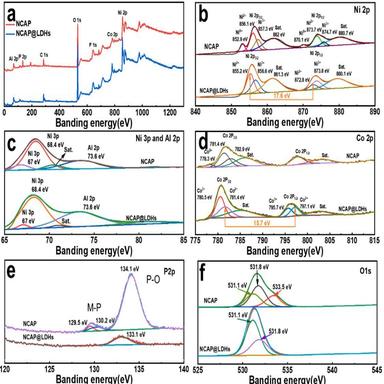
X-ray photoelectron spectroscopy (XPS) results of NCAP and NCAP@LDHs, survey (a), Ni 2p (b), Ni 3p and Al 2p (c), Co 2p (d), P 2p (e) and O 1s (f).